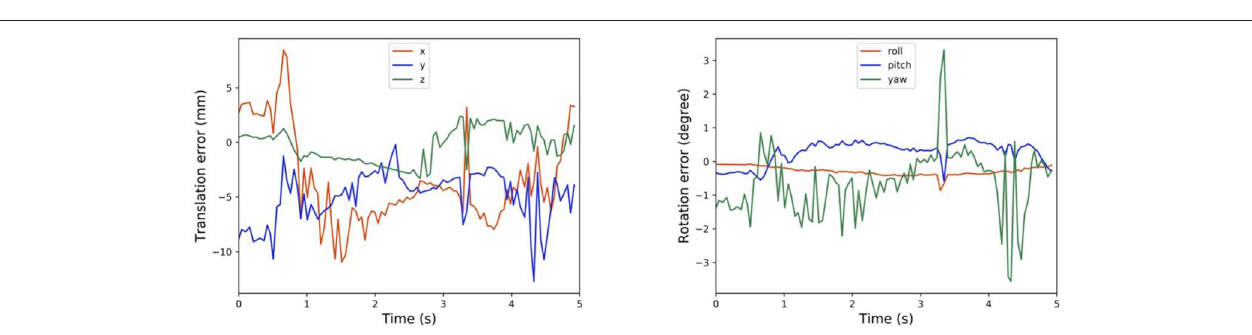
FIGURE 6 | Tracking calibration error using robot flange.